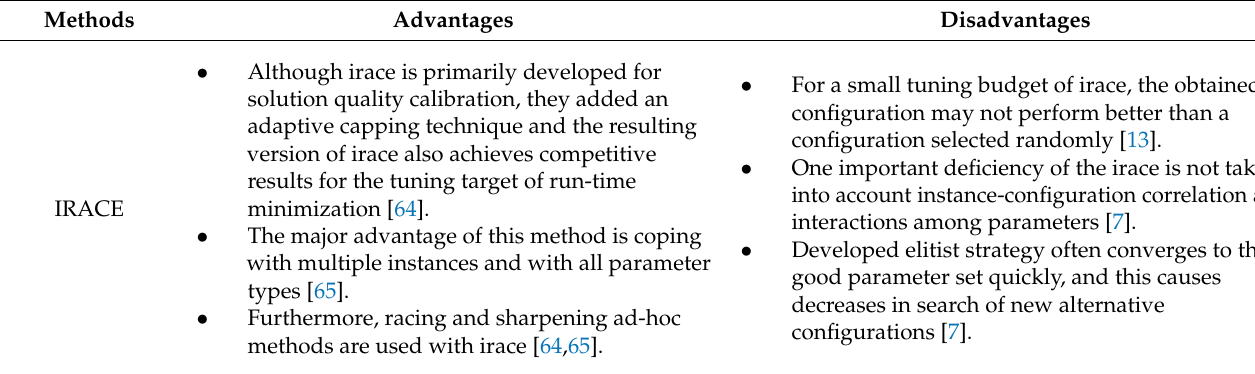
Table 2. A brief summary of advantages and disadvantages of irace and CALIBRA algorithm configuration